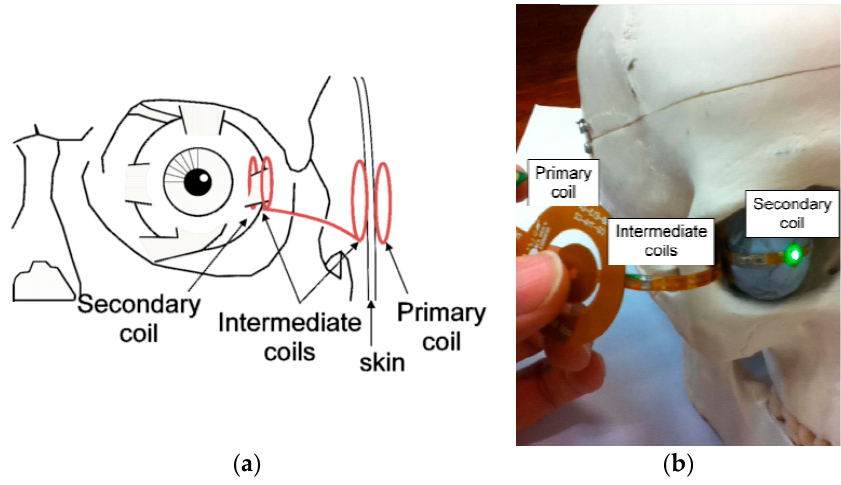
Figure 26. Multi-coil WPT retinal prostheses [147]. ( a ) Possible coil locations. ( b ) Measurement setup of two-pair coils system. Copyright © 2011, IEEE.